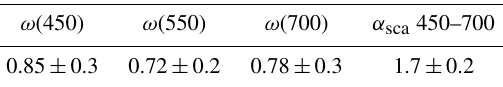
Table 5. Single scattering albedo ω(λ) (nephelometer wavelengths) and Scattering Angström Exponents, α sca , derived for 31 October 2012 (24h average) at Durlacher Tor,